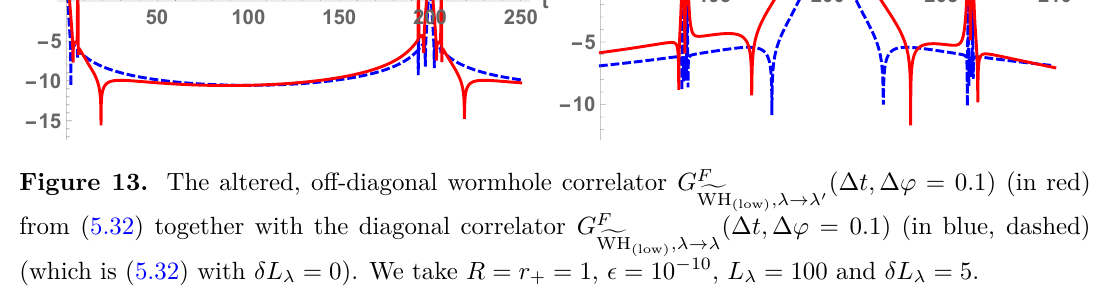
Figure 13. The altered, off-diagonal wormhole correlator G F from (5.32) together with the diagonal correlator G F (which is (5.32) with δL λ = 0 ). We take R = r + = 1 , (cid:15) = 10 − 10 , L λ = 100 and δL λ = 5 .